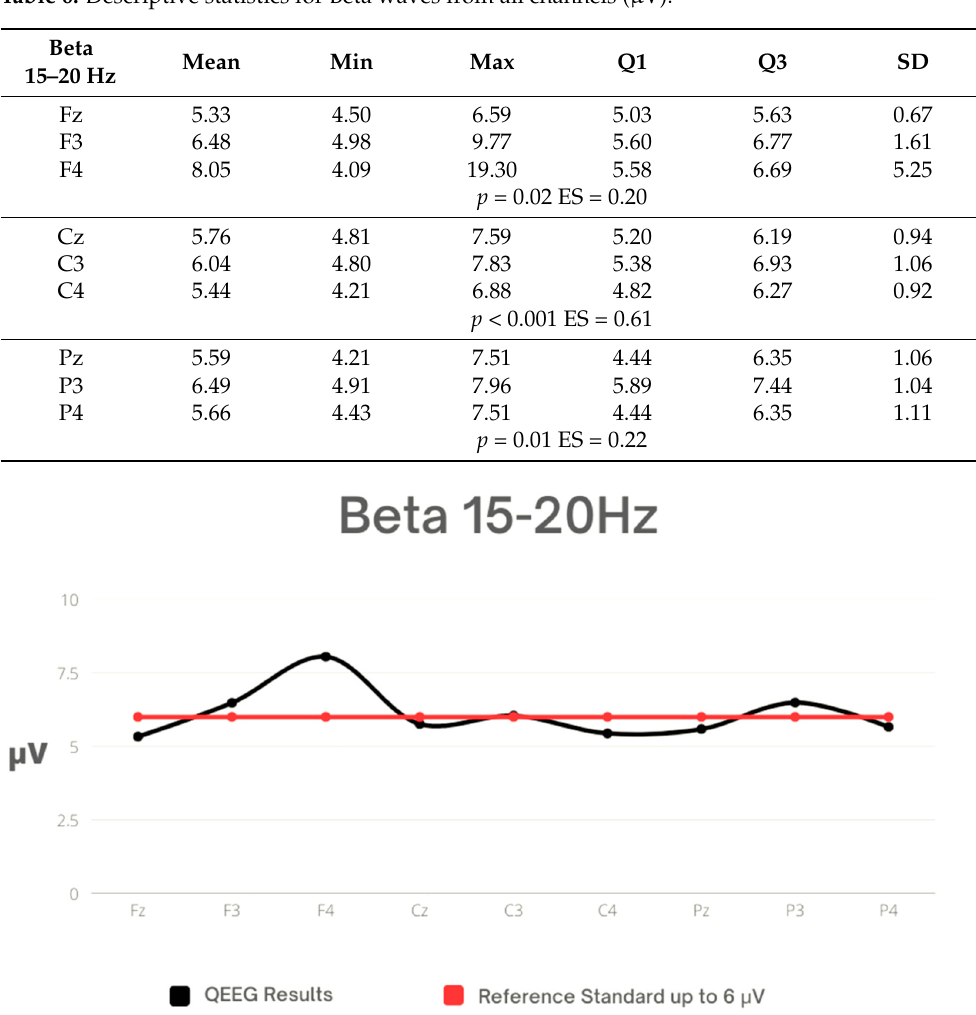
Figure 5. Mean values for Beta 1 against the reference